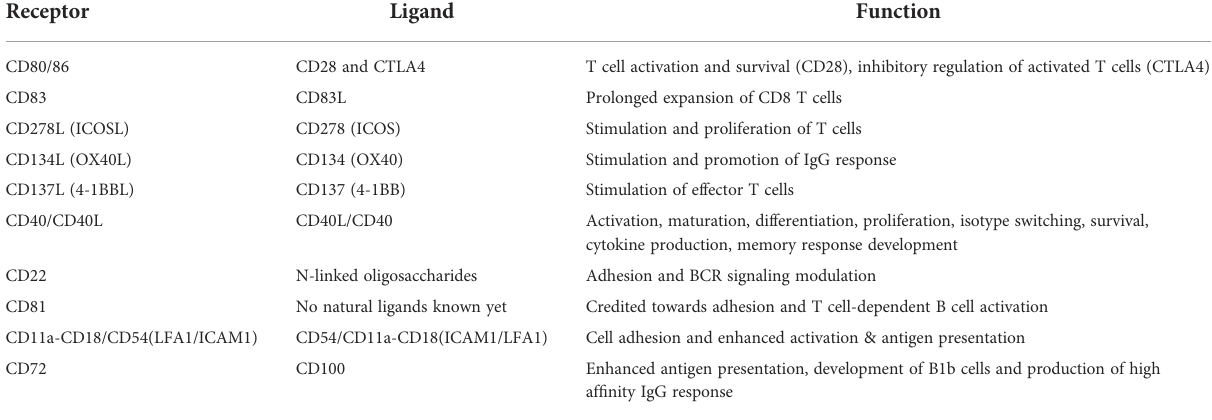
TABLE 3 Expression of co-stimulatory and activation molecules on B cells during antigen